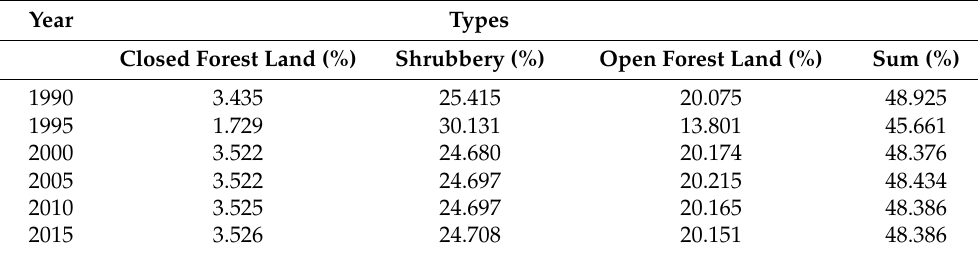
Figure 5. The distribution of temples and forest landscape from 1990 to 2015. Table 4. Within a buffer zone with a radius of 6 km, the proportion of the forest landscape around the temple in the total forest landscape.